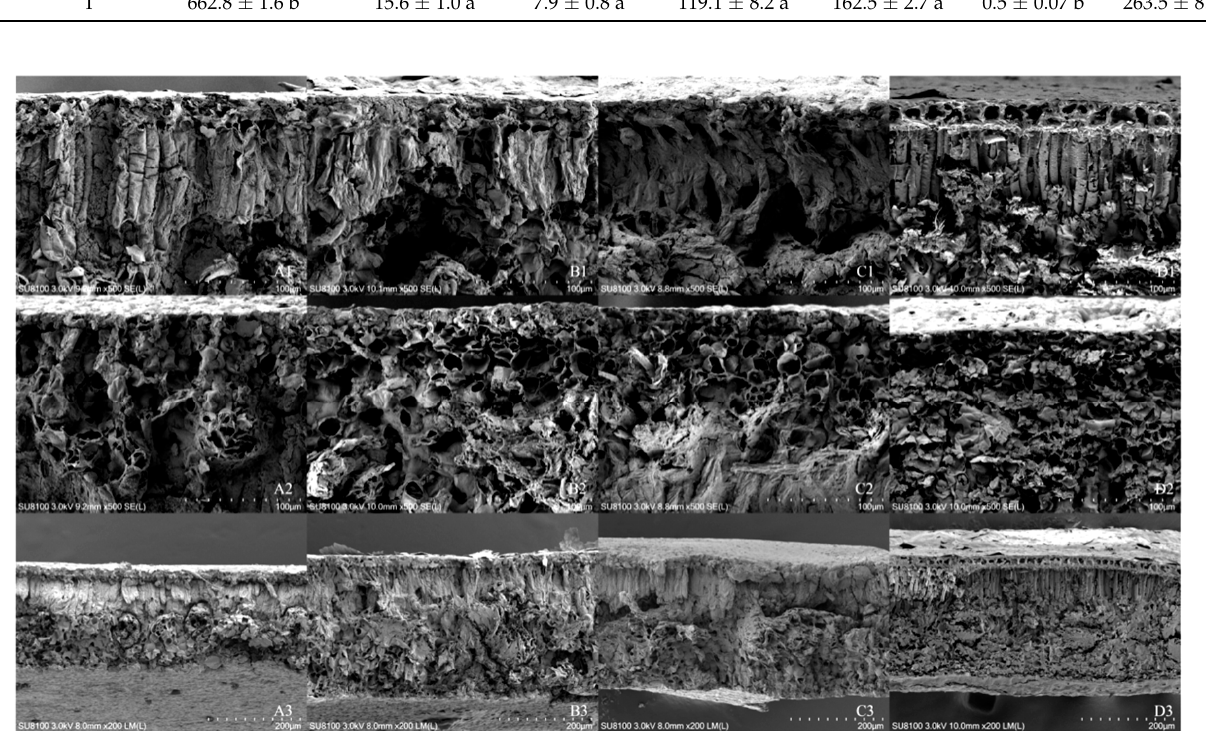
Figure 4. The effect of enhanced UV − B radiation on the microstructure of mesophyll cells in leaves.Note: ( A1 – A3 ). 2.7 CK; ( B1 – B3 ). 2.7 enhanced UV-B radiation; ( C1 – C3 ). 2.17 CK; ( D1 – D3 ). 2.17 enhanced UV-B radiation. The same scheme applies to the figures